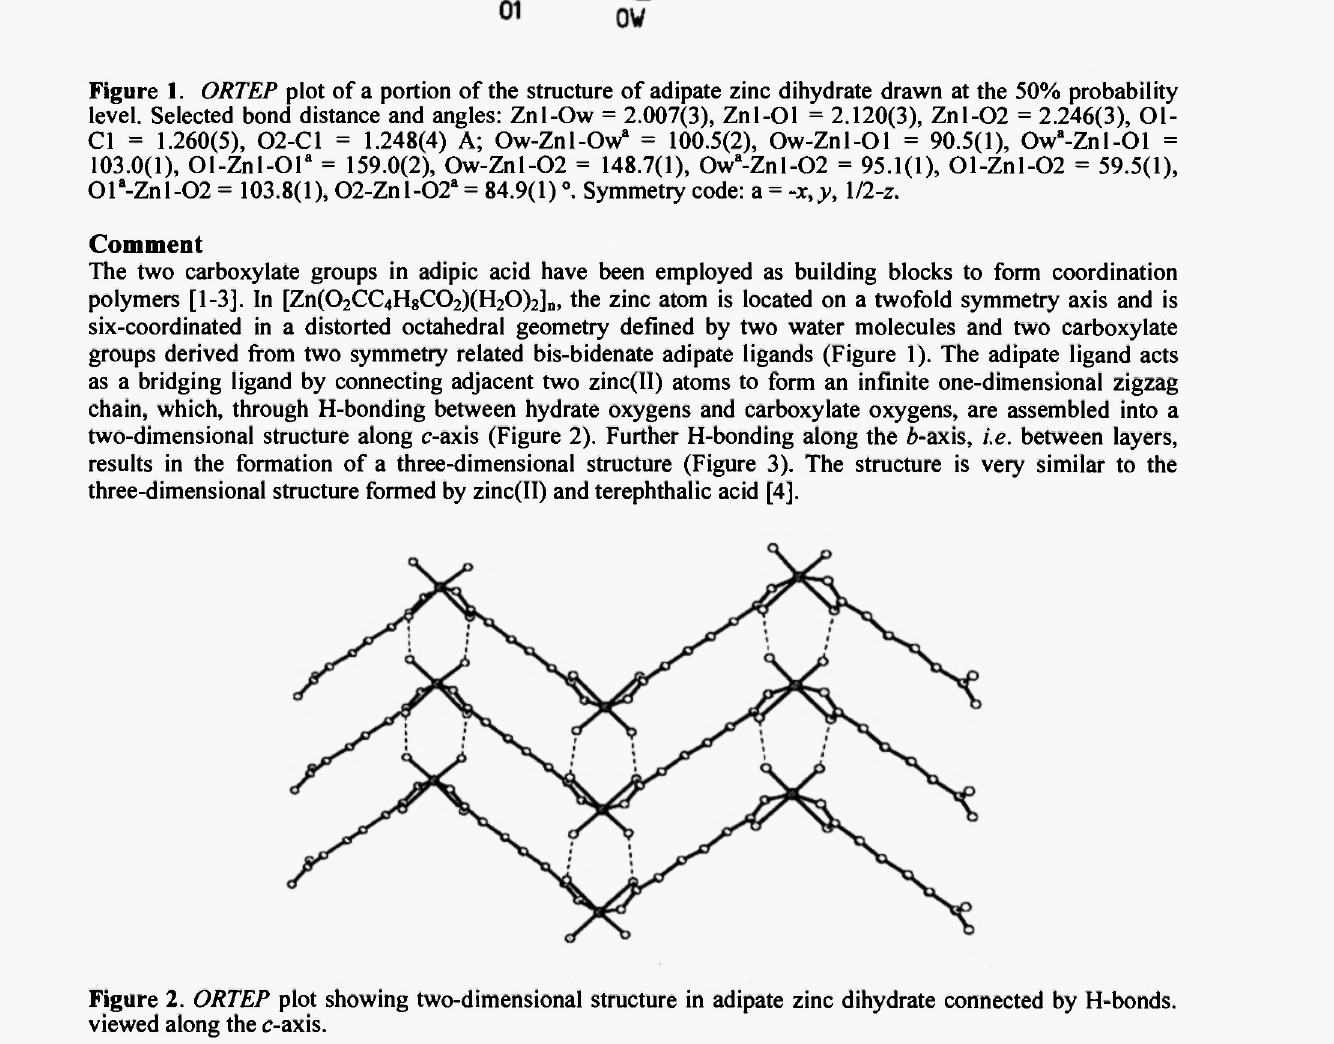
Figure 2. ORTEP plot showing two-dimensional structure in adipate zinc dihydrate connected by H-bonds. viewed along the